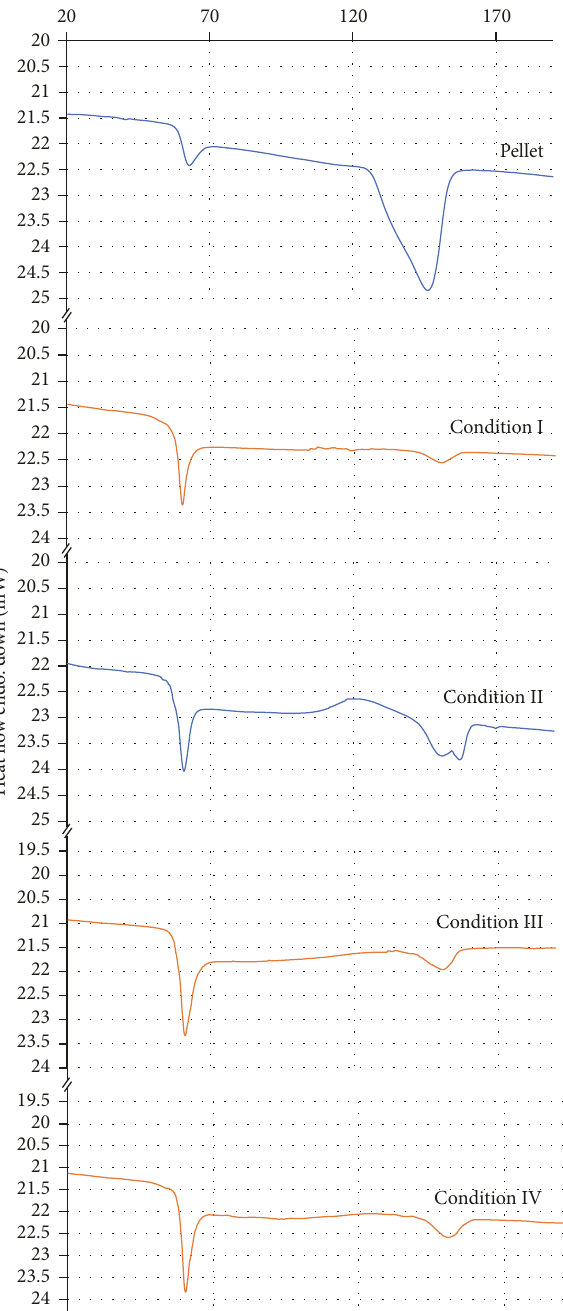
fractions, respectively, even though this value is very close to the detected 𝑇 𝑚